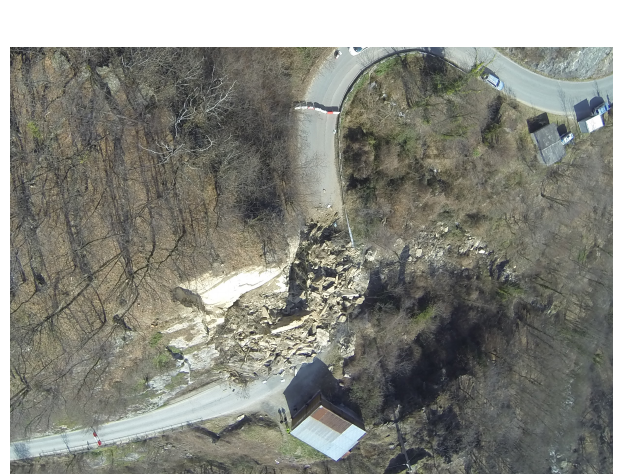
Figure 3. Example of RPAS image of a rockslide that occurred on a road. The image was acquired after the rockslide occurred in 2014 in San Germano municipality (Piemonte region, NW Italy). As pre- sented in Giordan et al. (2015a), a multi-rotor of the local Civil Protection Agency was used to evaluate damages and residual risk. RPAS images can be very useful as a representation of the occurred phenomena from a different point of view. Even if it has not already been processed using SfM applications, this data set can be very useful for decision makers for defining the management strategy of the first emergency